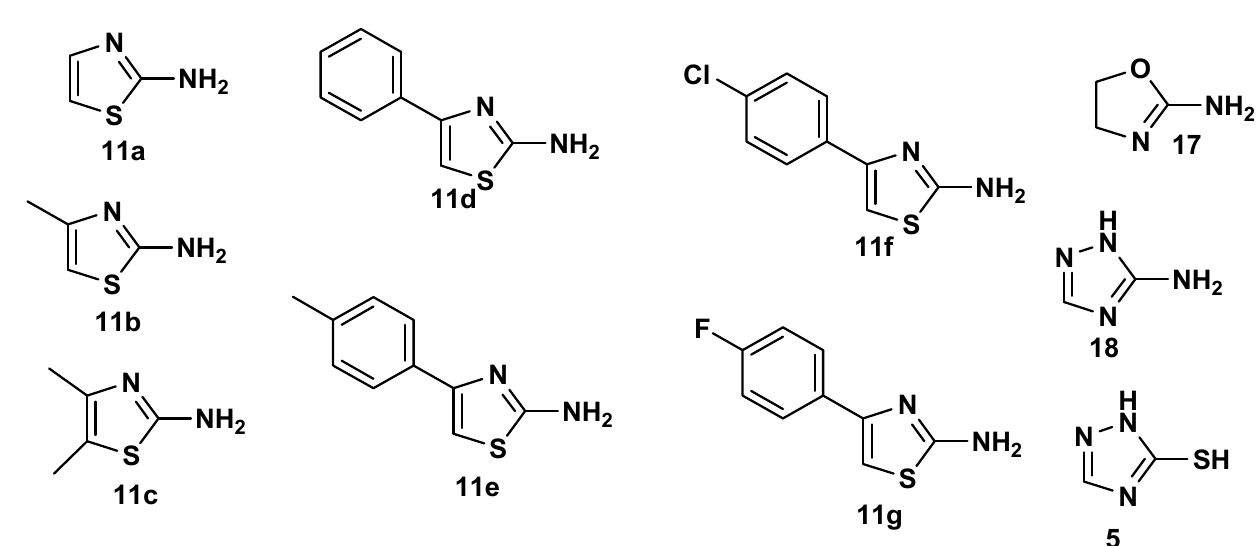
Figure 2. Five membered-ring substrates chosen for the reactions.